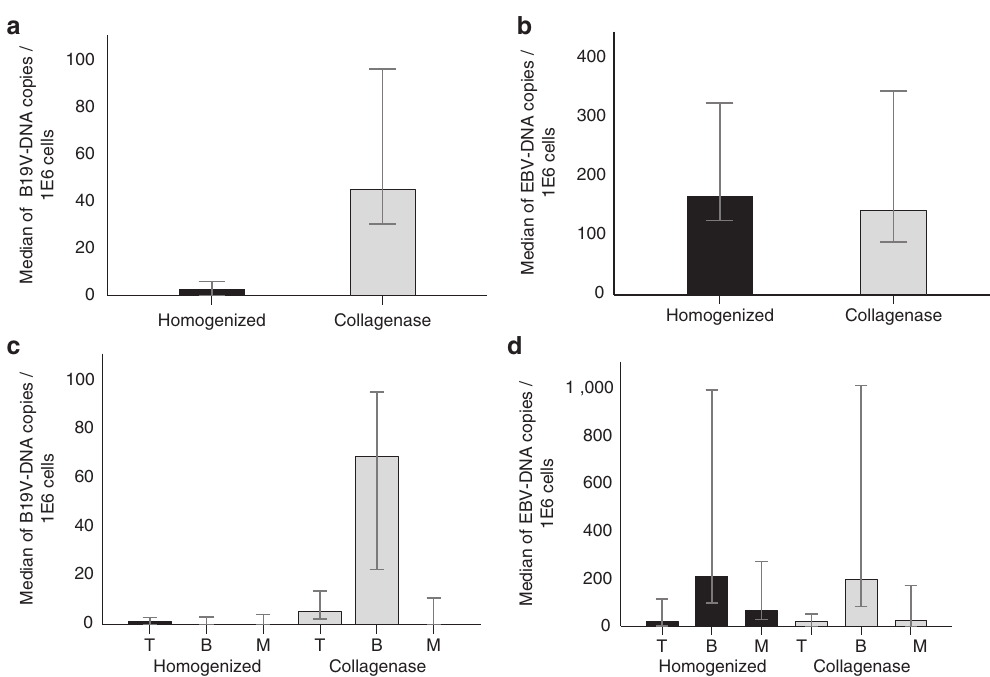
Figure 1 | Viral DNA copies in tonsillar tissue. B19V- and EBV-DNA copies were measured by qPCR and normalized to cell numbers with the human single-copy gene RNase P . Top panels: median copy numbers of B19V DNA ( a ) and EBV DNA ( b ) in tonsillar cell suspensions resulting from mechanical homogenization ( n ¼ 33) (black) or after collagenase treatment ( n ¼ 33) (light grey). The viral copy numbers between the two preparations were significantly different for B19V ( P o 0.001), while not significant for EBV ( P 4 0.05). Bottom panels: median copy numbers of B19V DNA ( n ¼ 33) ( c ) and EBV DNA ( n ¼ 24) ( d ) in T-, B- and monocytic cells following homogenization (black) or collagenase digestion (light grey). The viral loads in B cells were statistically significant between preparations for B19V ( P o 0.001) while not significant for EBV ( P 4 0.05). Error bars indicate 95% confidence intervals and were determined by normal approximation. Statistical significance was calculated with Mann–Whitney U asymptotic sig. (two-sided